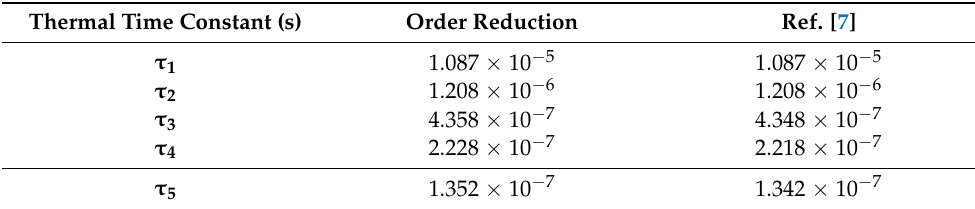
Table 2. Comparison between MOR results and the Bagnall Equation (9).